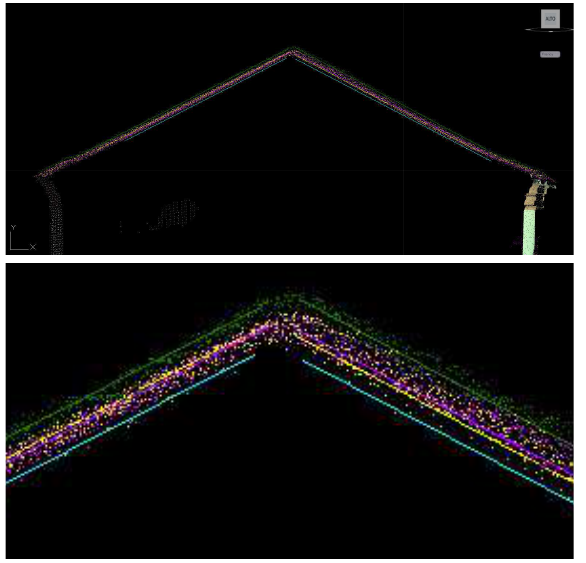
Figure 10. Comparison between the point clouds of the castle roof from TLS and from RPAS photogrammetry. In the enlarged detail of the cross section (section 2), the cyan line fits the TLS cloud, while the green, yellow and violet ones fit respectively the photogrammetric clouds from 40%, 80% 60% datasets.